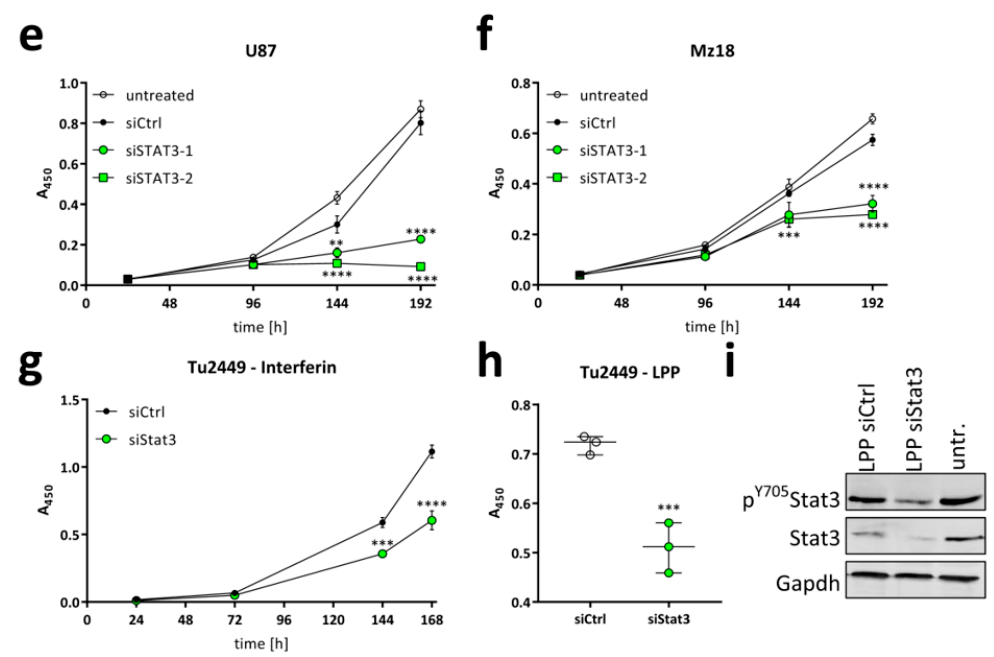
Figure 2. ( a ) Kaplan-Meier-Survival Plot from TCGA dataset GBM [40] showing that high STAT3 expression is associated with shorter survival; ( b , c ) qRT-PCR from ( b ) U87 and ( c ) Mz18 human glioma cell lines after transfection with control siRNA (siCtrl) or two siRNAs against STAT3 (siSTAT3-1 and siSTAT3-2). STAT3-expression was normalized to Actin as housekeeper and siCtrl-transfected cells as control sample using the ∆∆ Ct-method. The data are presented as box-plots (min-to-max) with all samples displayed as circles; the horizontal line in the box depicts the median value, the plus-symbol the mean. ( d ) Western Blot of U87 and Mz18 after transfection as in ( b , c ) after transfection of siCtrl, siSTAT3-1 or siSTAT3-2. ( e – h ) Proliferation (WST-1) assays of the human glioma cell lines ( e ) U87 and ( f ) Mz18, using INTERFERin and the two different siSTAT3 for comparison, and in the murine glioma cell line Tu2449 after transfection with ( g ) INTERFERin TM or ( h ) LPP. The data in ( e – g ) are presented as mean +/ − SEM; the data in ( h ) are presented as Box-Plots (min-to-max) with all samples displayed. ( i ) Western Blot of Tu2449 cells 96 h after transfection with 150 pmol LPP siCtrl or LPP siStat3. ( b , c ) shows the summary of at least three independent experiments performed in biological duplicates; ( d ) was performed twice; ( e , f , h ) were performed three ( g ) two times in biological triplicates; ( i ) was performed three times. **: p < 0.01; ***: p < 0.001 and ****: p < 0.0001 compared to siCtrl treatment.